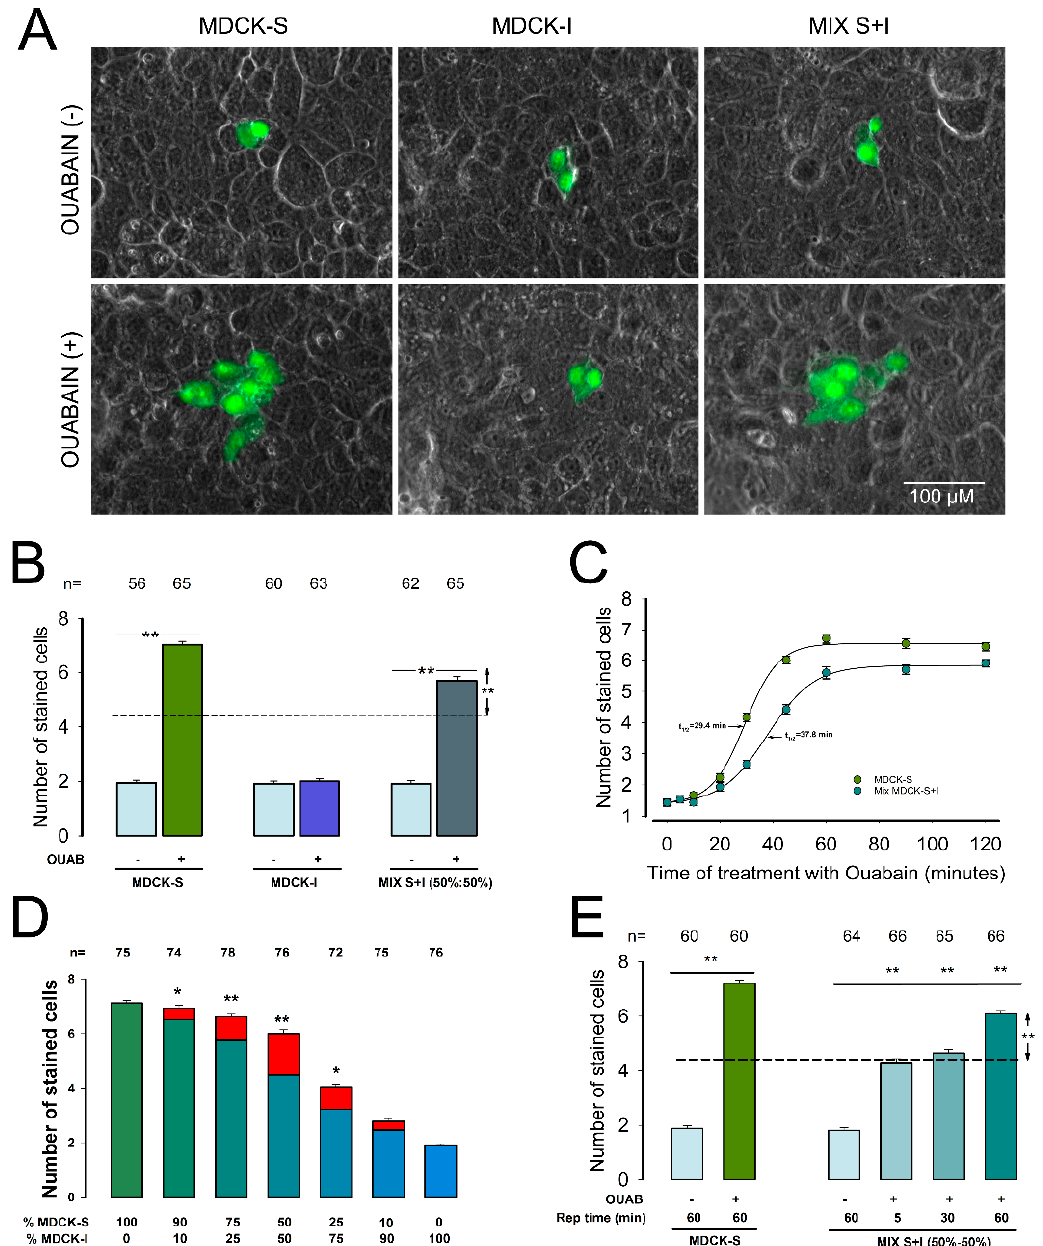
Figure 1. Ouabain insensitive cells (MDCK-I) are turned GJIC responsive when co-cultures with sensitive (MDCK-S) cells. ( A ) Images showing representative examples of Lucifer Yellow transfer trials. The green mark corresponds to LY dye, whereas the gray background is a phase contrast field showing the integrity of the monolayer. The images were selected to match the median of each indicated experimental condition. ( B ) Bar chat comparing the average value of the number cells stained with LY ( X SC ) with and without treatment with ouabain (OUAB) in monolayers of MDCK-S, MDCK-I or monolayers made of mixed types. ( C ) Plot comparing the time course of the effect of ouabain in monolayers of MDCK-S and mixed monolayers. The continuous lines result from fitting data to a sigmoidal curve by non-linear regression to get (t 1/2 ). ( D ) Bart chart comparing X SC of monolayers of distinct proportions of MDCK-S and MDCK-I as indicated at the foot of bars. (*) and (**) indicate statistically significant difference, with p < 0.01 or p < 0.001 respectively, after comparing the experimental value with the theoretical, that X SC would have in case no GJIC would occur in MDCK-I. ( E ) Bar chart comparing X SC of MDCK-S monolayers with and without treatment with ouabain (10 nM, 1 h) and in mixed monolayers after treatment with ouabain 10 nM with media replaced at regular intervals up to 60 min. The dashed line indicates the theoretical value that X SC would have in case of MDCK-I cells woul not communicate. (**) indicates statistically significant difference ( p < 0.001) of the groups that separates the lines. The values above bars indicate the number of